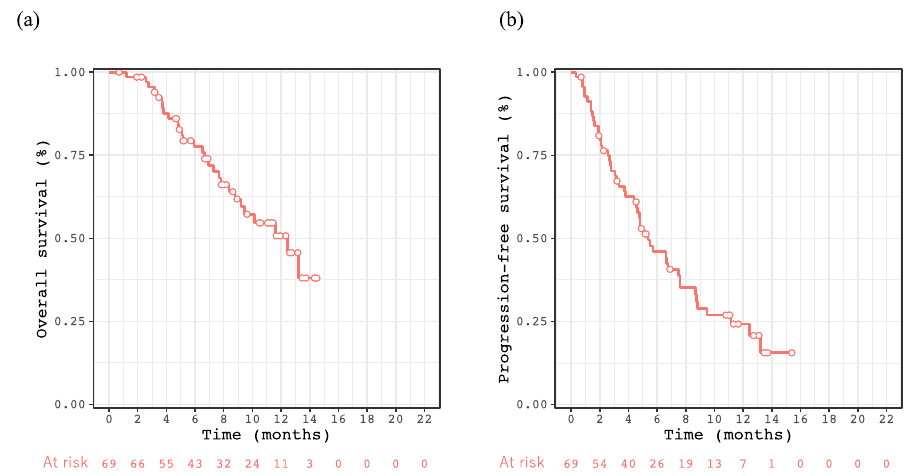
Figure 1. Kaplan–Meier curve for overall survival after the introduction of atezolizumab plus bevacizumab treatment for unresectable HCC ( a ) and for progression-free survival ( b ).